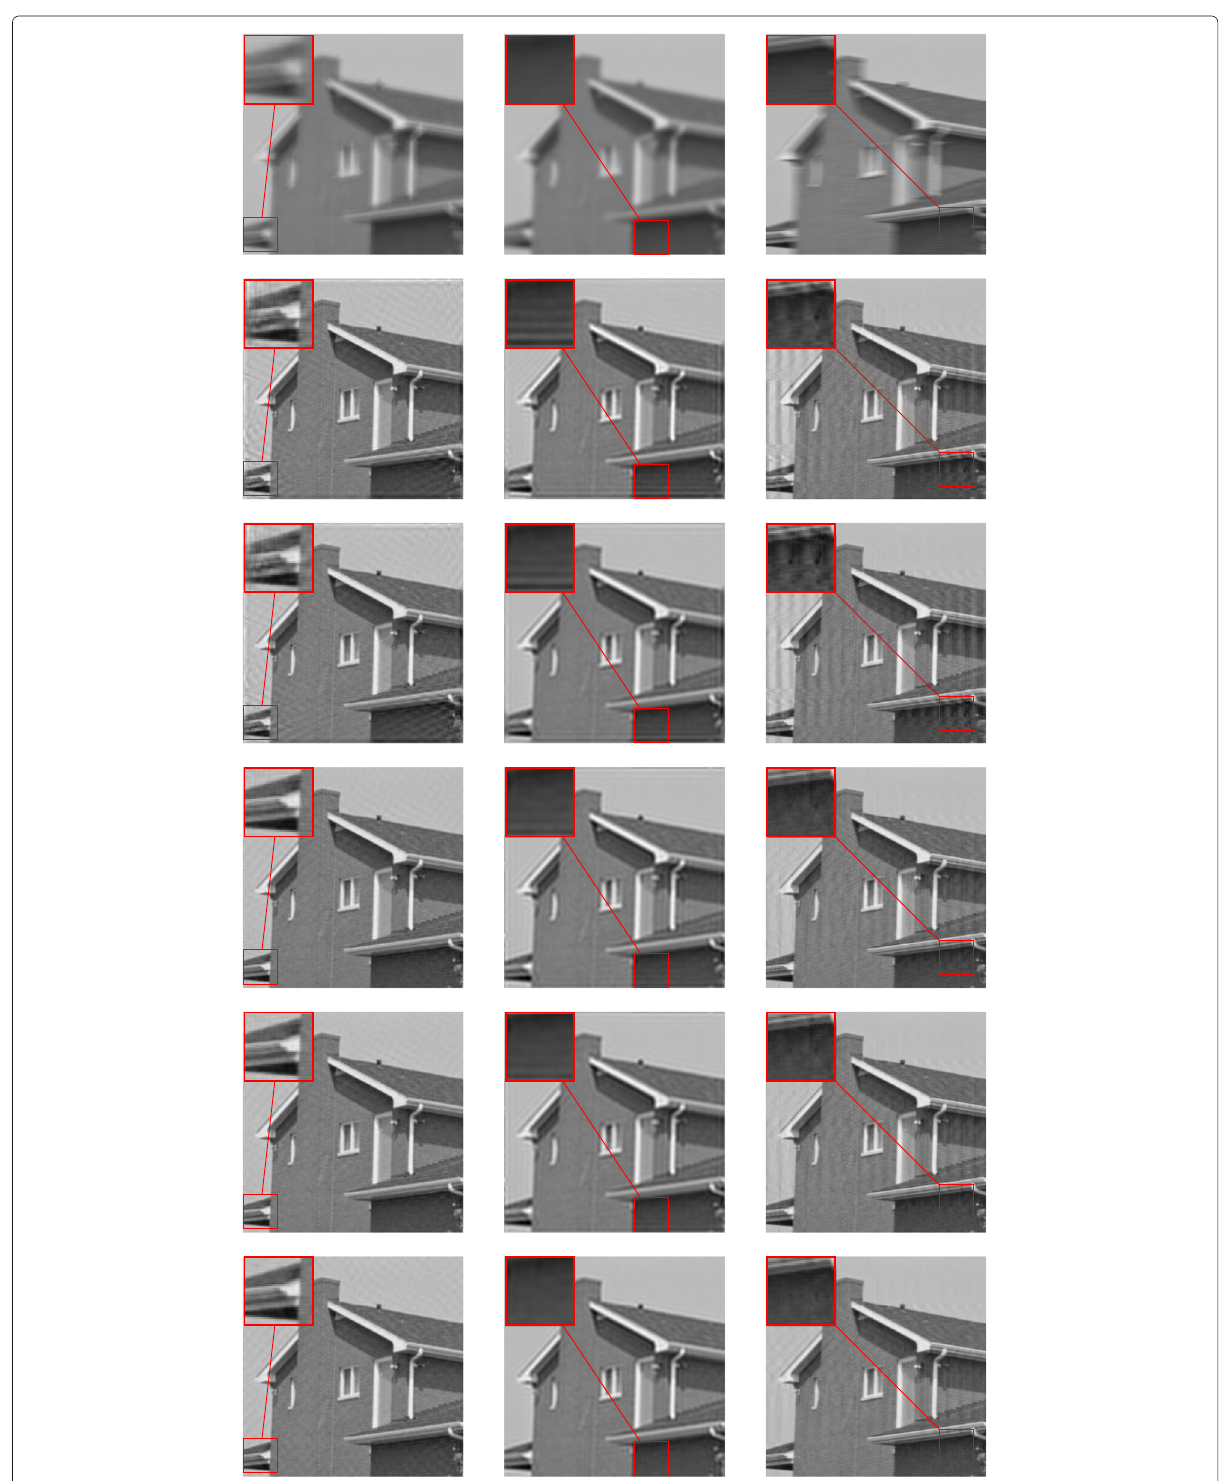
Fig. 5 Deconvolution of House image. From left to right, the first column represents degradation by kernel 1, the second column for the degradation by kernel 2, and by kernel 3 in the third column. From top to bottom, the order of the rows is as follows: blurred images using the three kernels respectively, restored images using RL algorithm [11] (kernel 1 (iterations = 70), kernel 2 (iterations = 140), and kernel 3 (iterations = 40)), restored images using Wiener filter [9], restored images using TV method [14], restored images using BTV approach [16], and finally the restored images using our proposed MAP- H 1